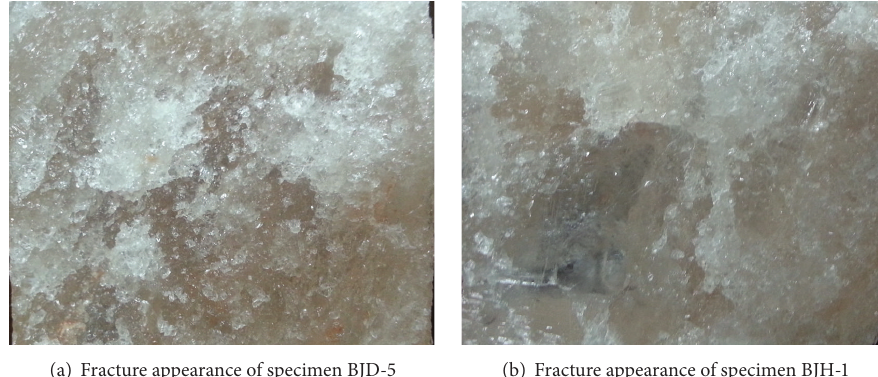
Figure 10: Fracture morphology of salt rock specimen.